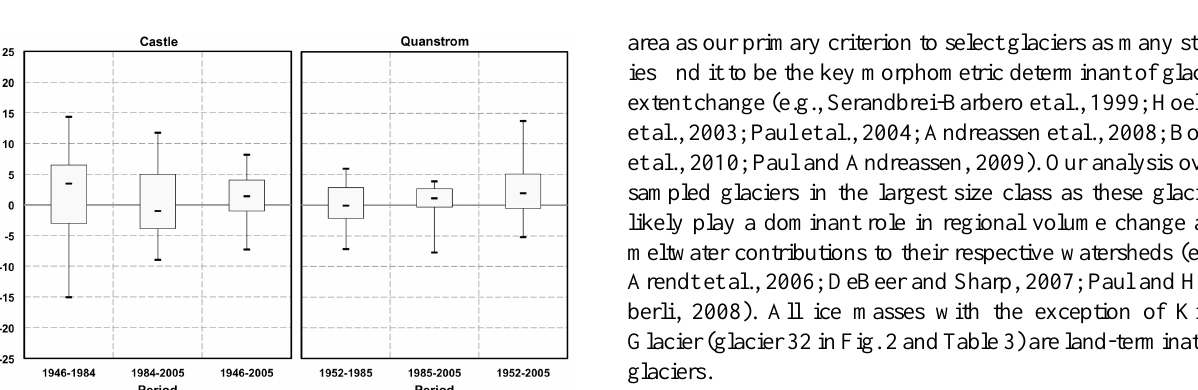
Figure 2. Cariboo Mountains subregions showing subset of 33 glaciers, including extents for 1952, 1970, 1985, and 2005. Panels show from left to right the Castle, Quanstrom, and Premier subregions. Numerical glacier identification, numbered by 2005 surface area from smallest to largest, corresponds to that of Tables 2 and 3.